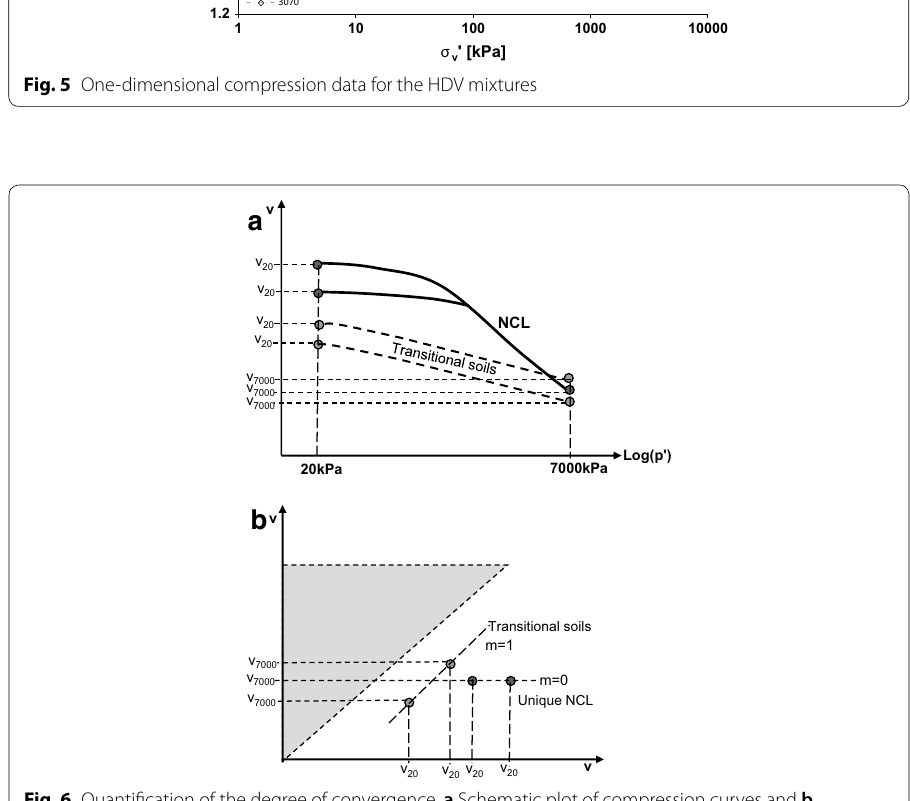
Fig. 6 Quantification of the degree of convergence. a Schematic plot of compression curves and b calculation of m (Modified after Ponzoni et al.